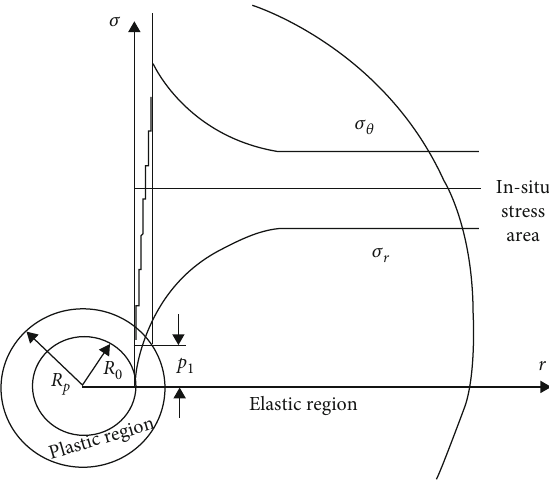
Figure 3: Stress variation law of the surrounding rock of the